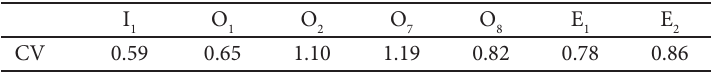
Table 5. Coefficient of variation of model variables